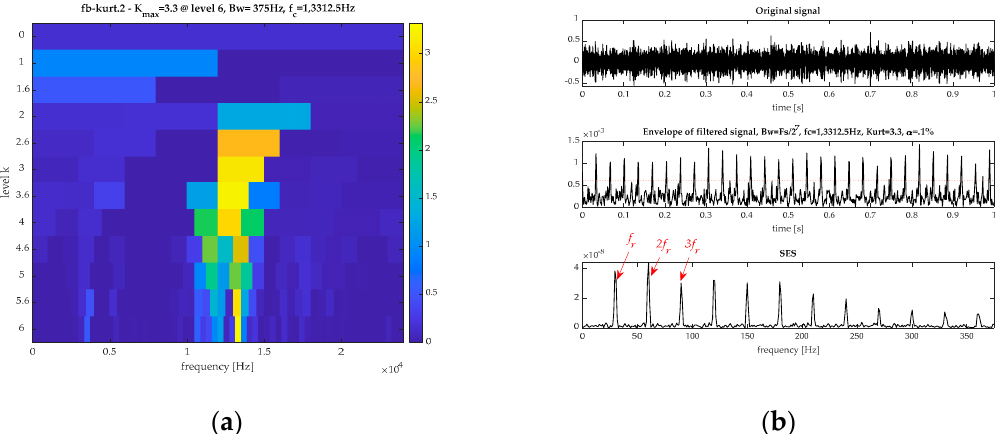
Figure 19. The results by FK for the ball fault signal: ( a ) spectrum kurtosis and ( b ) the filtered signal and its SES.